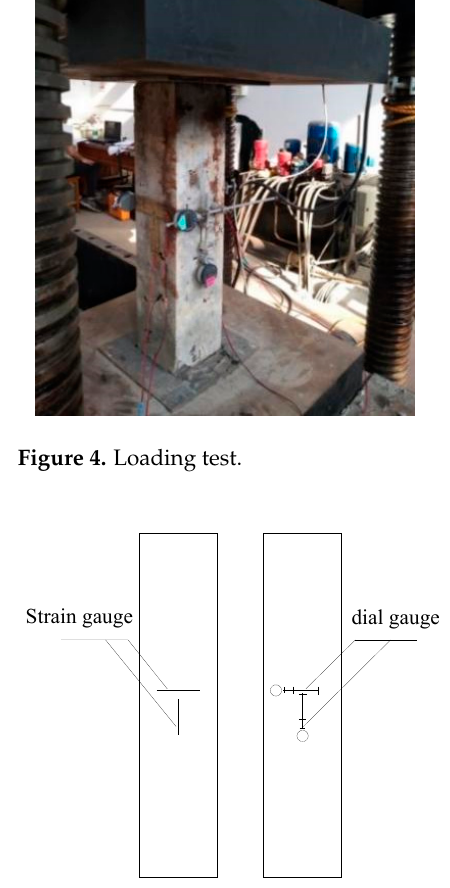
Figure 5. Measuring instrument arrangement.